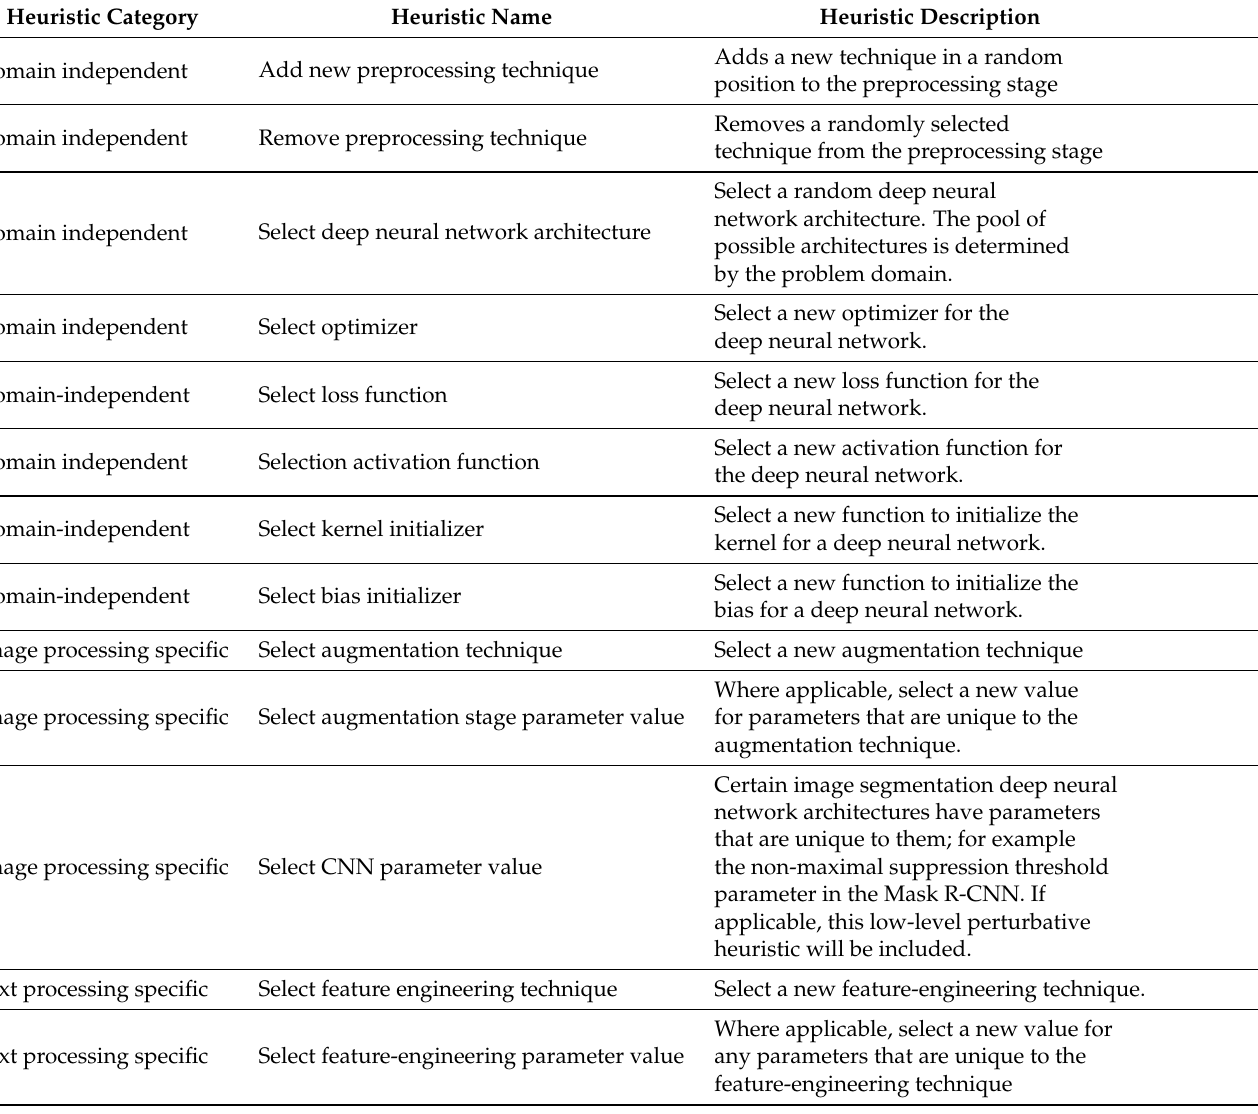
Table 3. This table lists the low-level perturbative heuristics the SPHH uses. For each heuristic, the category, name and description is